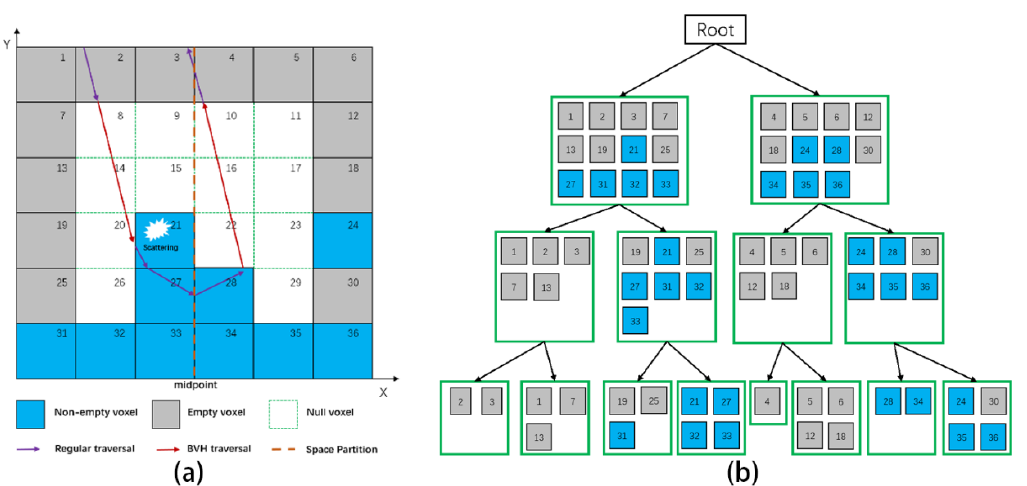
Figure 3. Hybrid scene structuring scheme: ( a ) The structure of a typical scene with non-uniform geometry distribution, ( b ) The corresponding bounding volume hierarchy (BVH) tree which organizes all the non-null voxels.